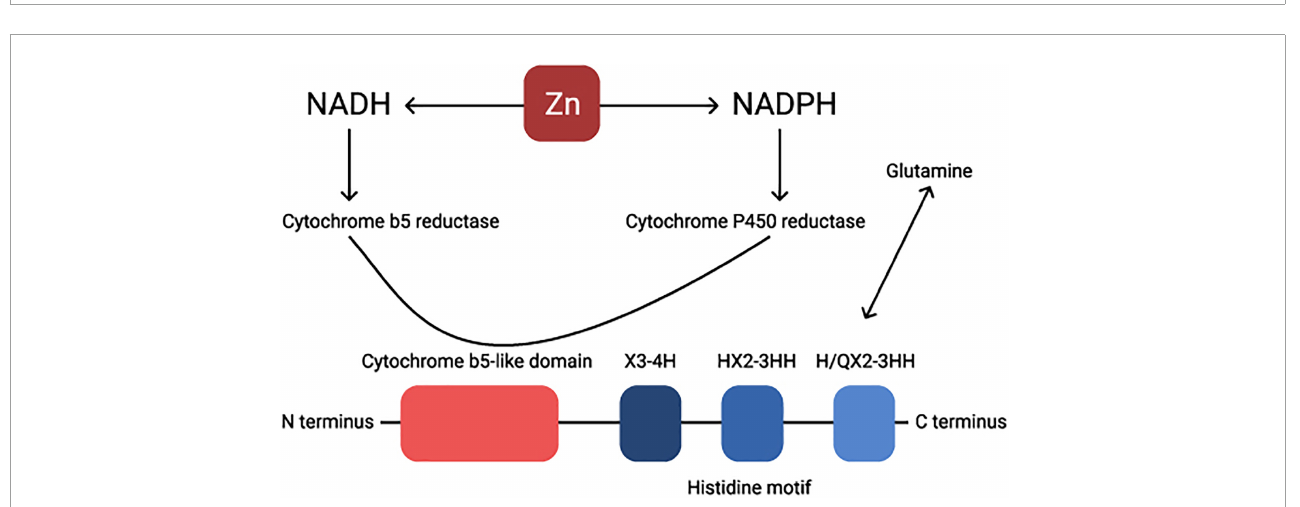
FIGURE2 Visual presentation of the structure of a (cid:49) 6 desaturase enzyme. Zn regulates NADH-NADPH cycle. Cytochrome P-450 activity is considerably diminished under Zn deficiency. NADH, nicotinamide adenine dinucleotide hydride; NADPH, nicotinamide adenine dinucleotide phosphate-oxidase.